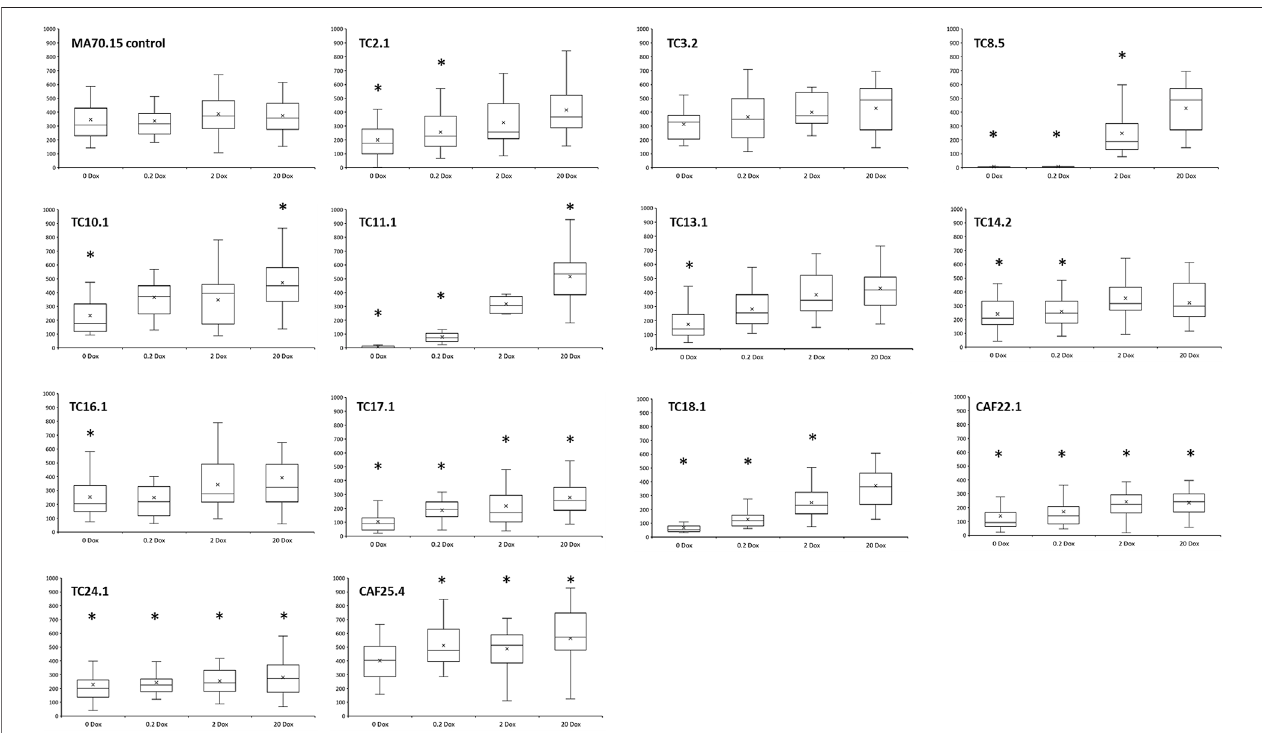
FIGURE 4 | Quanti fi cation of hyphal length following growth on MM agar at 30 ° C for 18 h. Dox concentrations are indicated. Strains with values that signi fi cantly deviate from progenitor control at the respective Dox concentration are indicated with an asterisk ( t -test). Approximately 25 hyphae per strain/Dox condition were analysed. Y -axis: Hyphal length